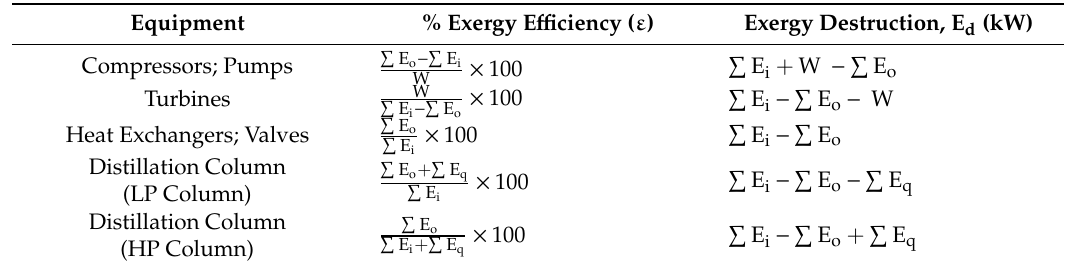
Table 9. Definitions of % exergy e ffi ciency of various equipment